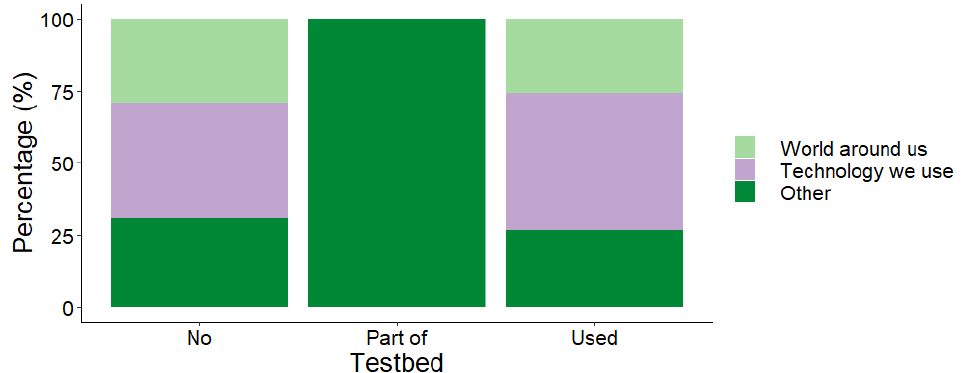
Figure 34. Deployment distribution between usage of testbed facilities and deployment field. World